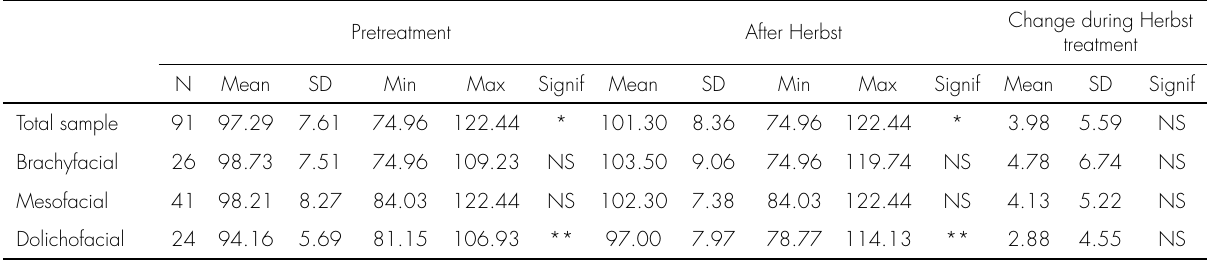
SD = Standard deviation, Min = minimum value, Max = maximum value, Signif = ANOVA, significant differences in means, NS = Not significant. * = p ≤ 0.05 ** = p ≤ 0.05, significant difference in vertical pattern subgroup Table VIII. Mandibular length (Co-Gn) (mm).